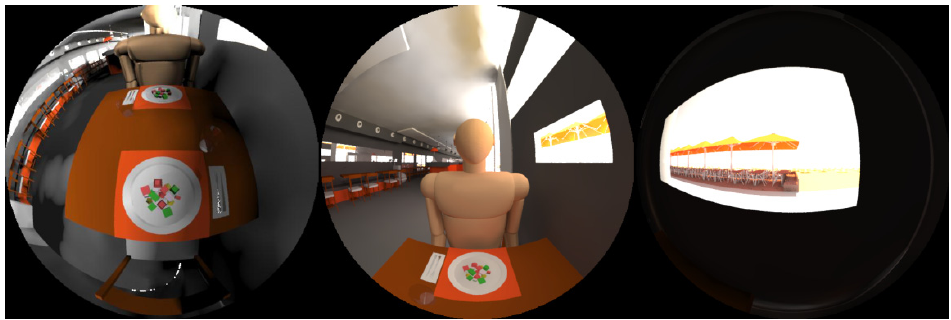
Figure 8. Simulated pictures of window façade system of Sal Café restaurant with each workplane; table, a person in front and window.